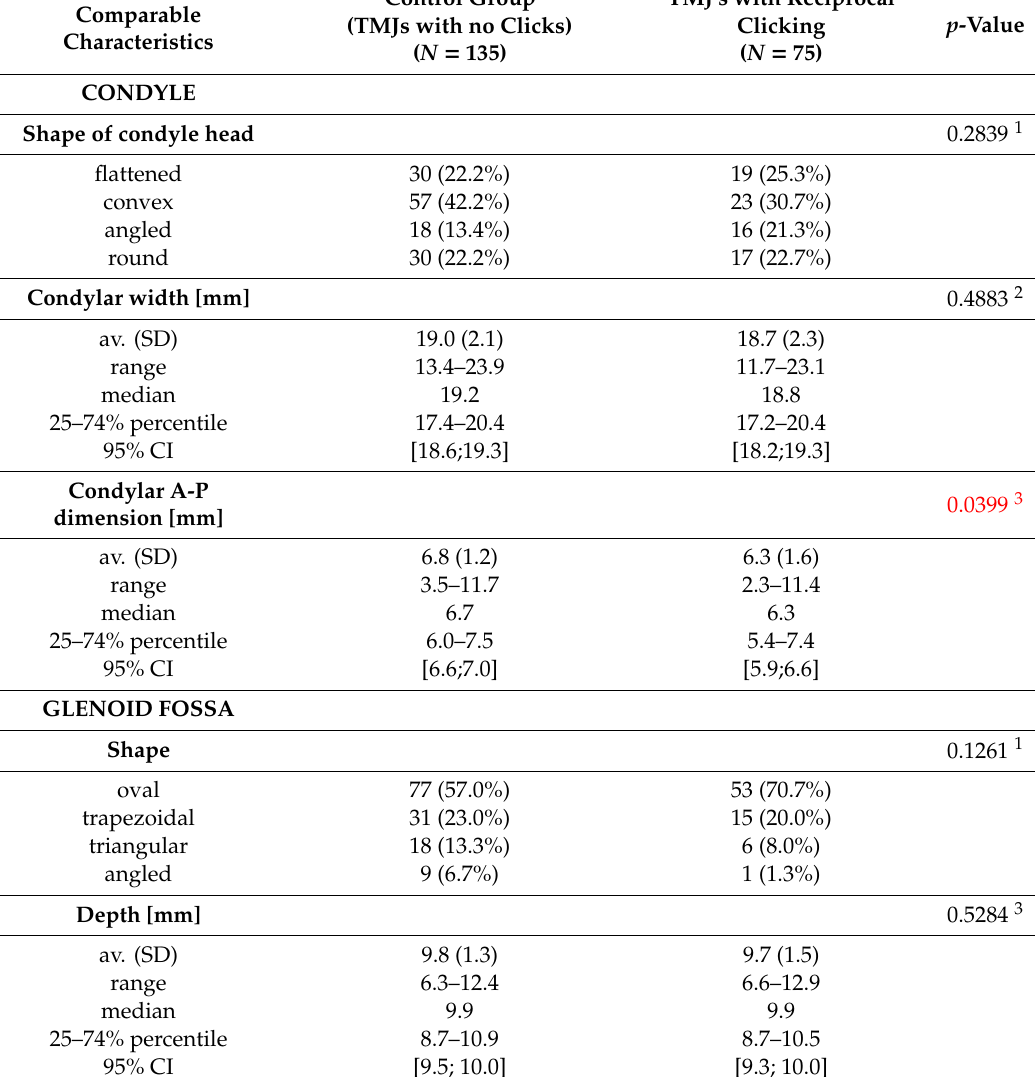
Table 2. Comparable characteristics of condyle’s head, glenoid fossa, and articular eminence as well as condylar head position in glenoid fossa and osteoarthritic changes in the area of condylar head regarding the presence of reciprocal